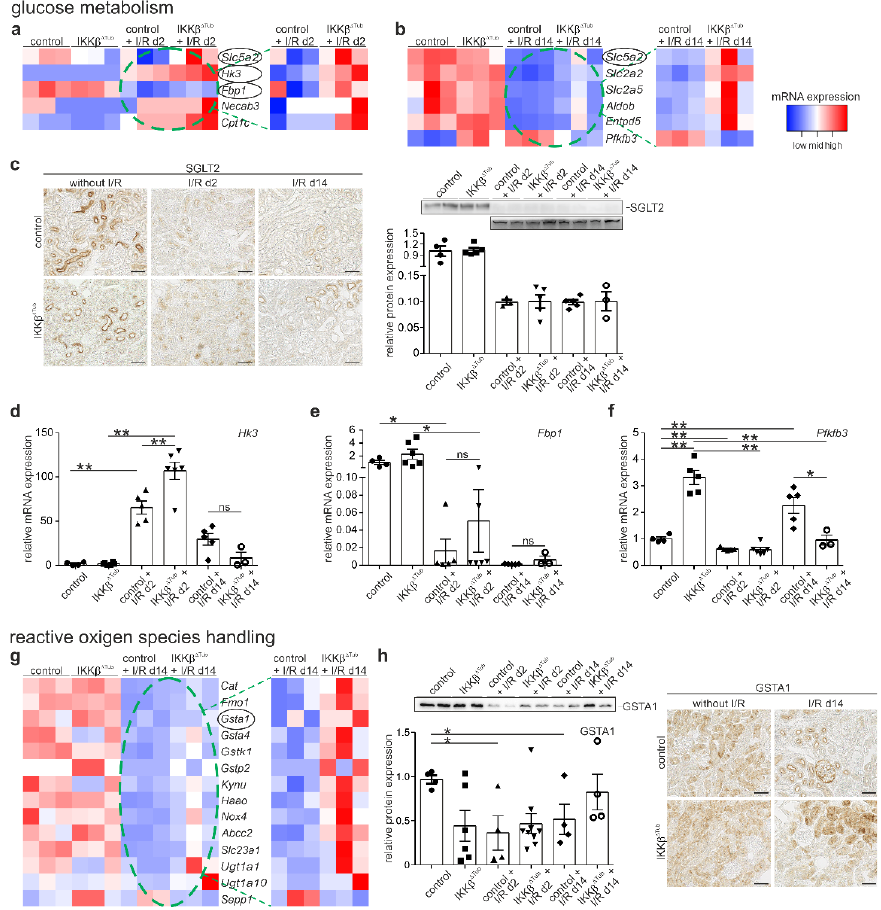
Figure 4. Tubular deletion of IKK β affects glucose metabolism and reactive oxygen species handling after I/R injury. ( a , b ) heatmaps of significantly altered mRNA of proteins known to affect glucose